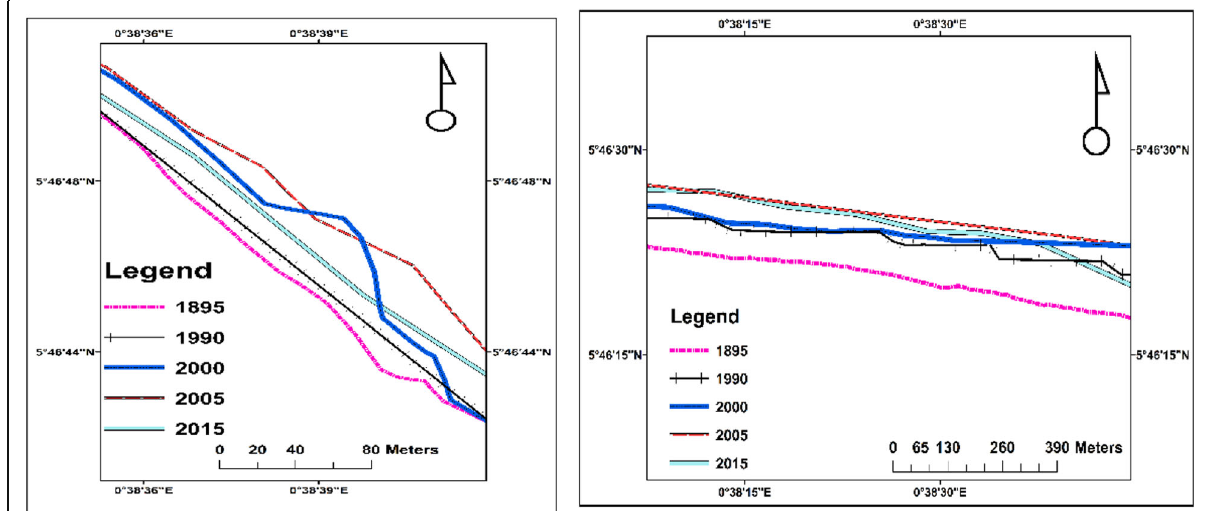
Fig. 5 Merged coastline positions on the marine